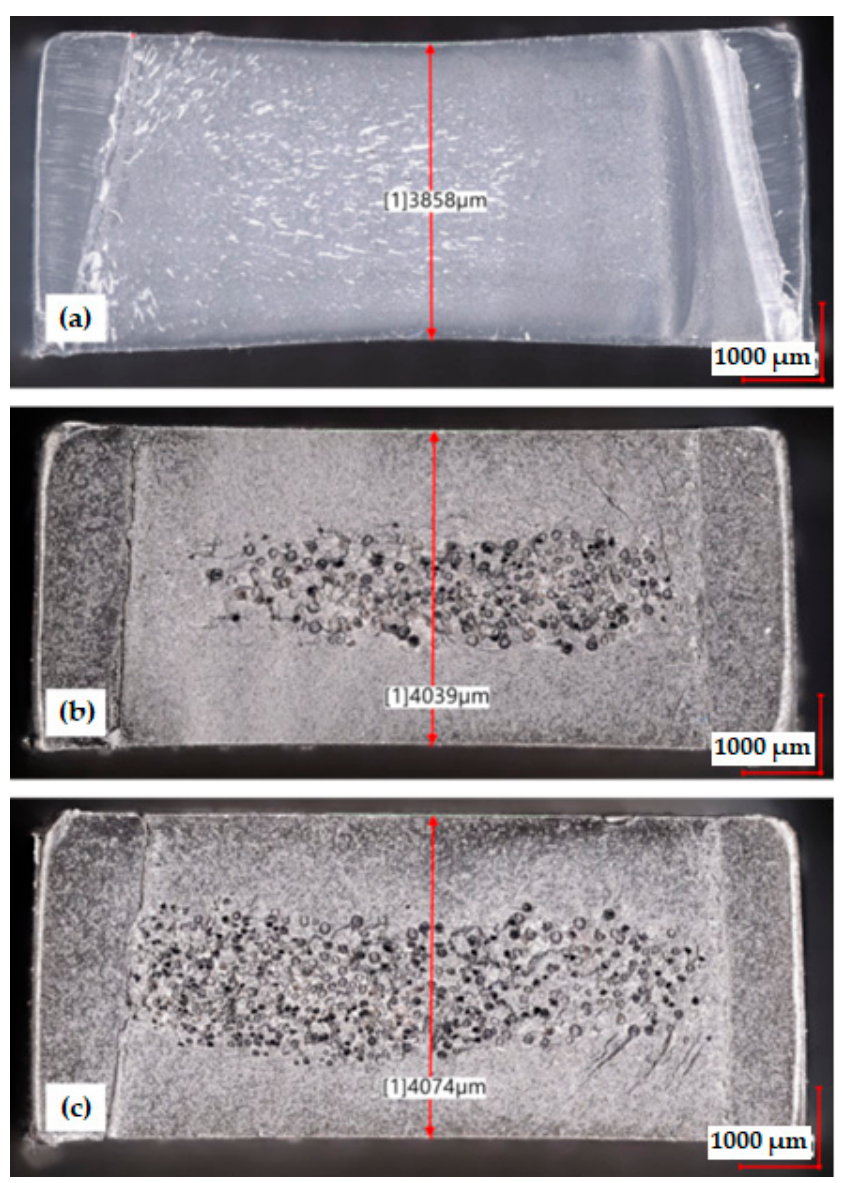
Figure 6. Distribution of pores in the cross-section for each of the series 168 h after them from the injection mold: ( a ) PP sample ( b ) PP-C4 sample ( c ) PP-C0 sample . injection mold: ( a ) PP sample ( b ) PP-C4 sample ( c ) PP-C0